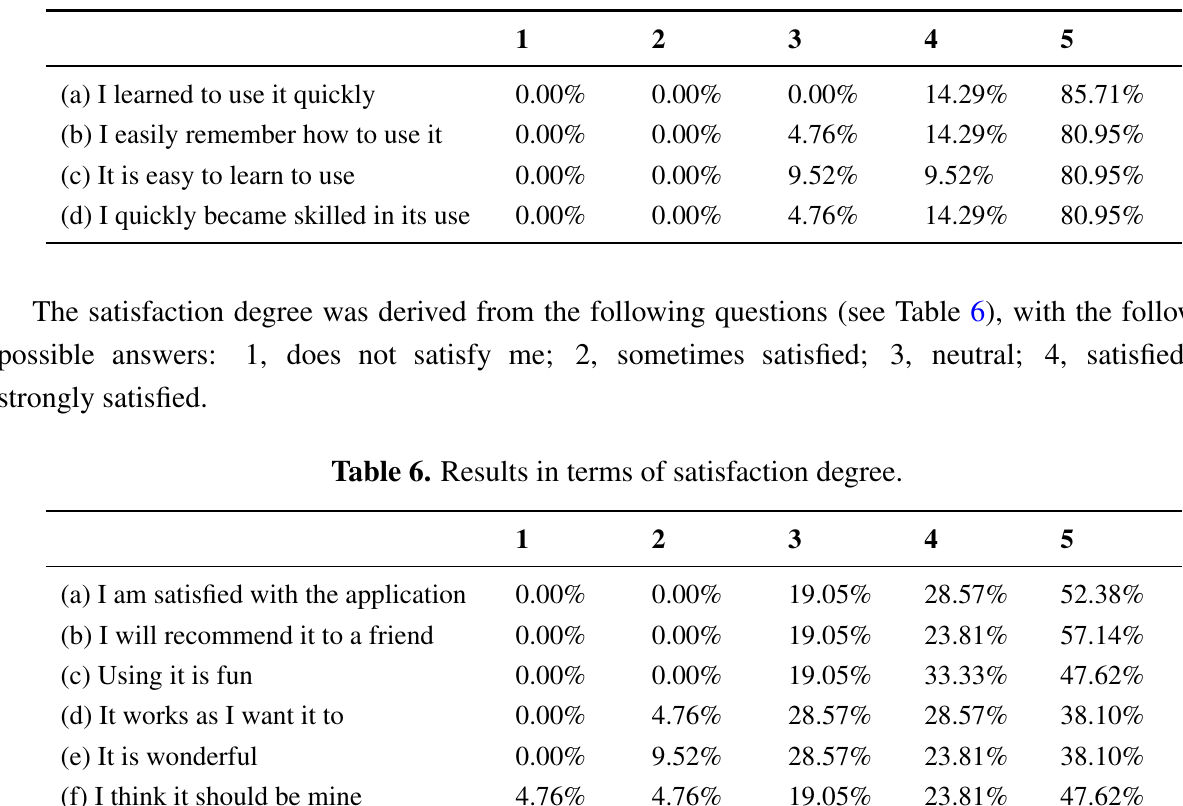
Table 5. Results in terms of learnability of the application.